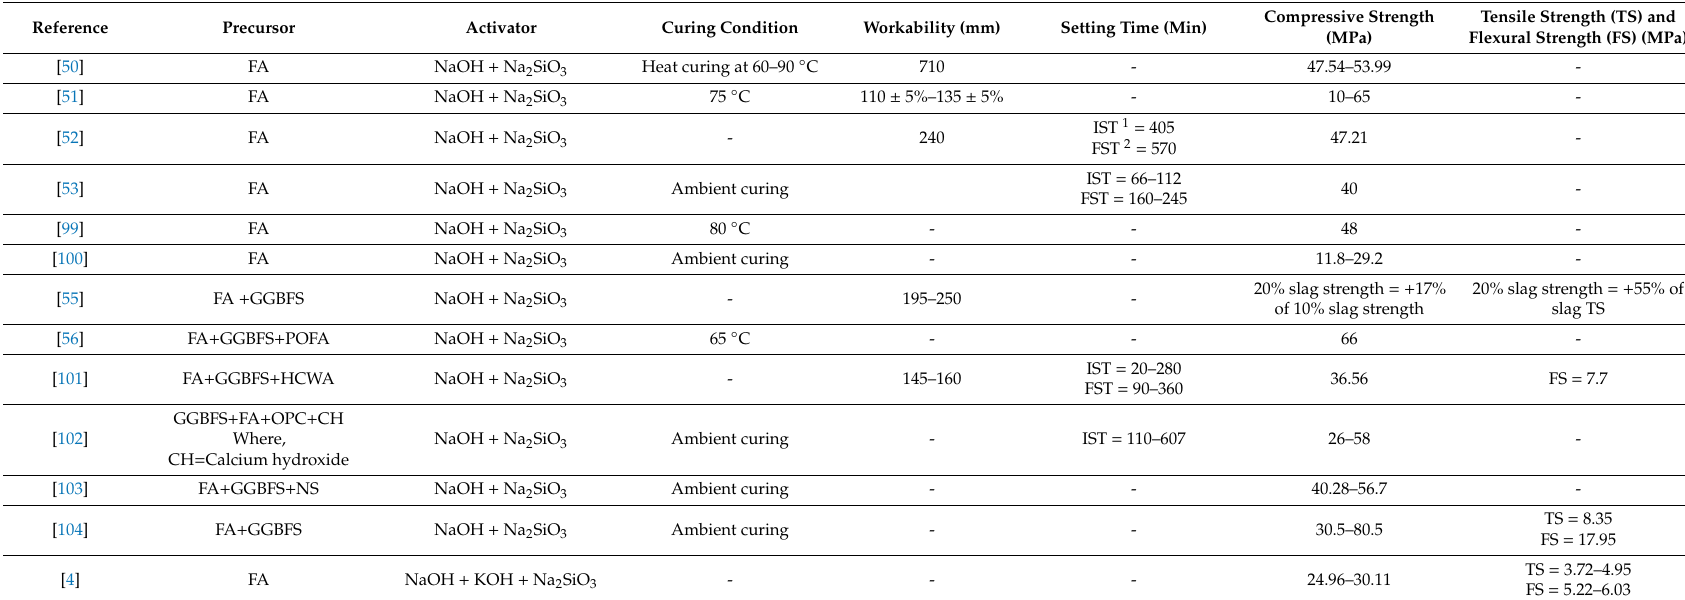
Table 5. Fresh and hardened properties of